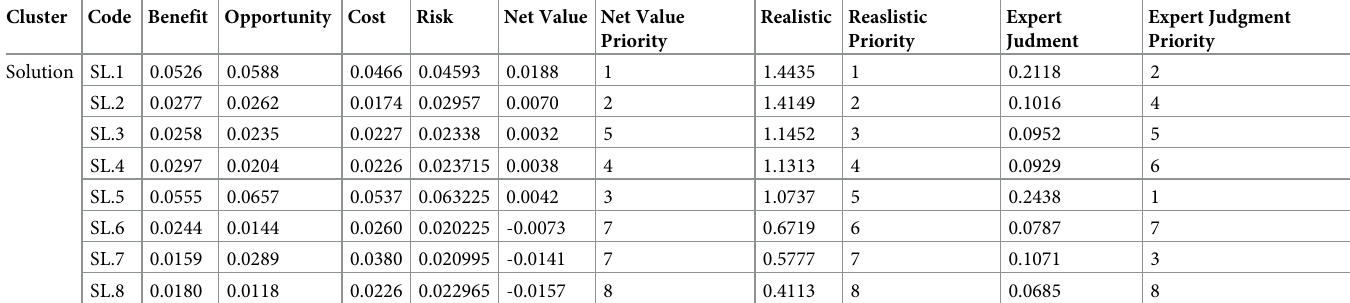
Table 4. ANP results of solution.